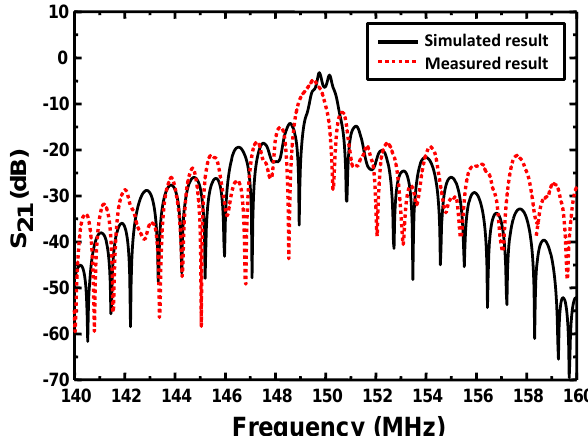
Figure 5. The simulated and measured response characteristics of the proposed Love wave device.